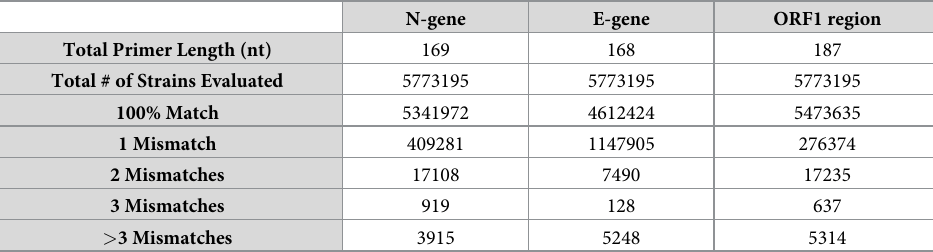
Table 3. In silico inclusivity